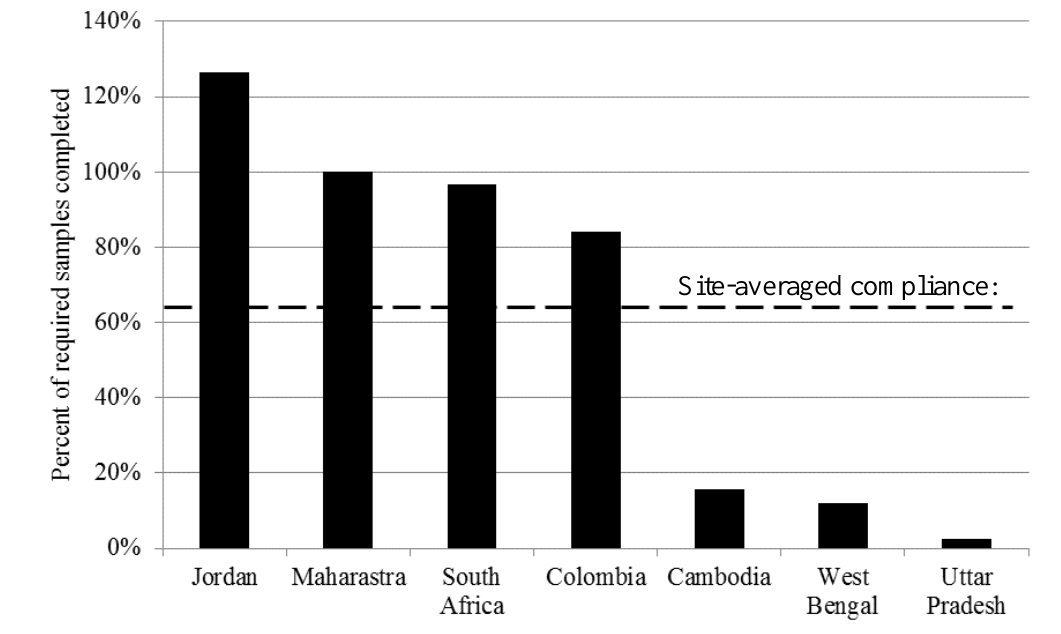
Figure 3. Compliance with monitoring requirements by country.